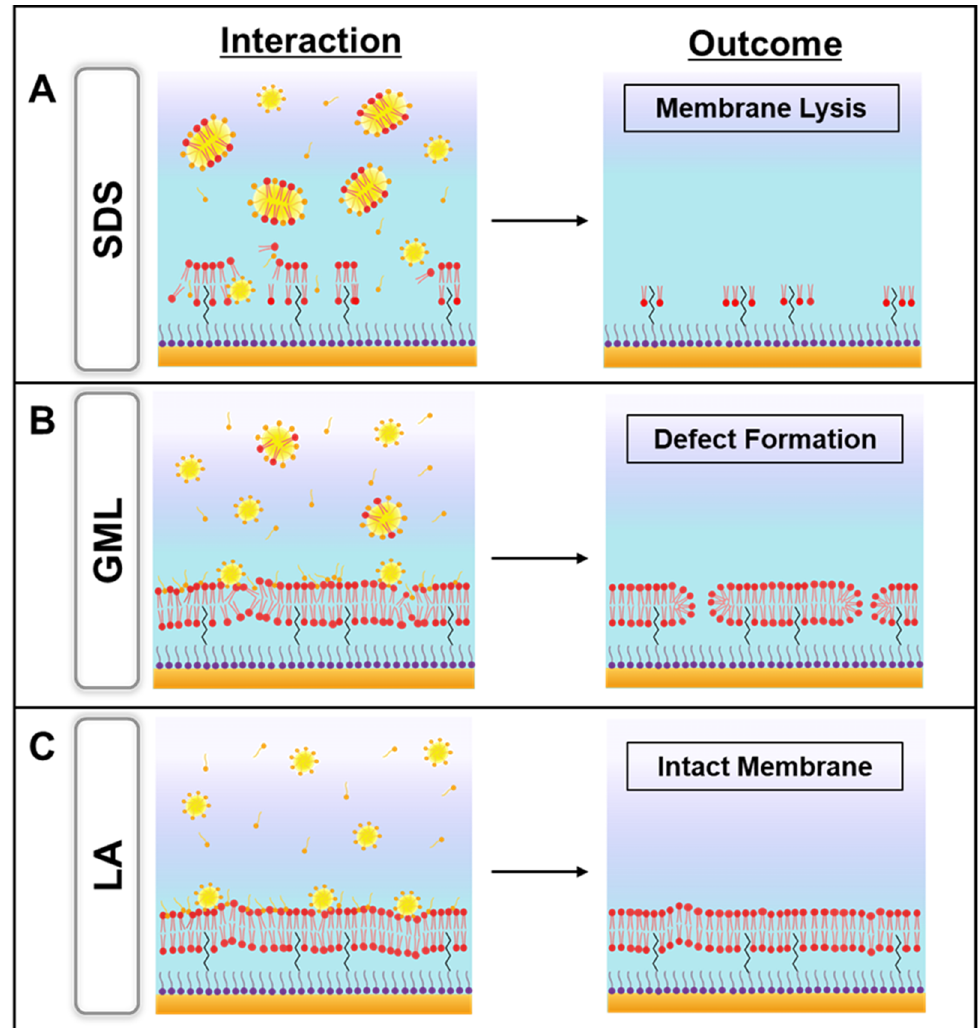
Figure 6. Schematic summary illustrating the membrane-disruptive effects of ( A ) SDS, ( B ) GML, and ( C ) LA micelles on tethered bilayer lipid membrane platforms. The inferred scenarios reflect the EIS measurement trends observed in each case and are proposed based on the wealth of antimicrobial peptide data that has been obtained for tBLM platform experiments using the EIS technique in past reports [33,36].